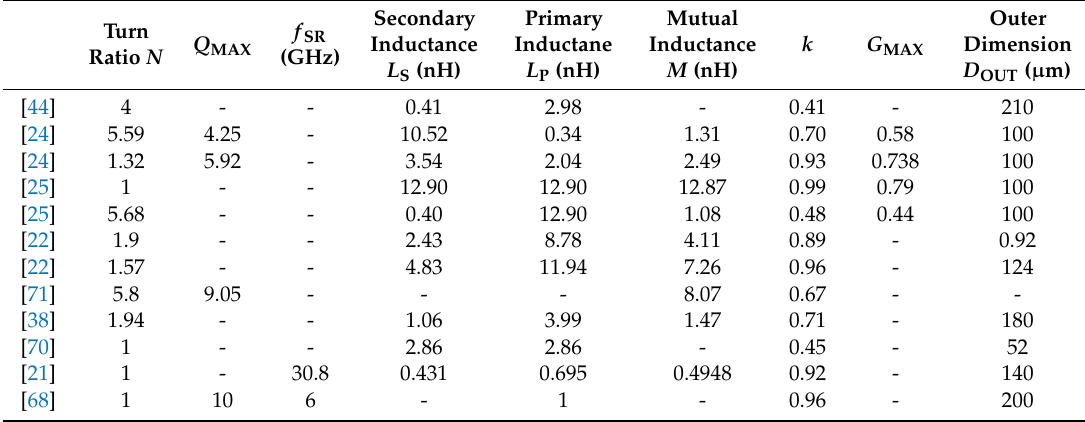
Table 2. Comparison of di ff erent on-chip transformers using stacked